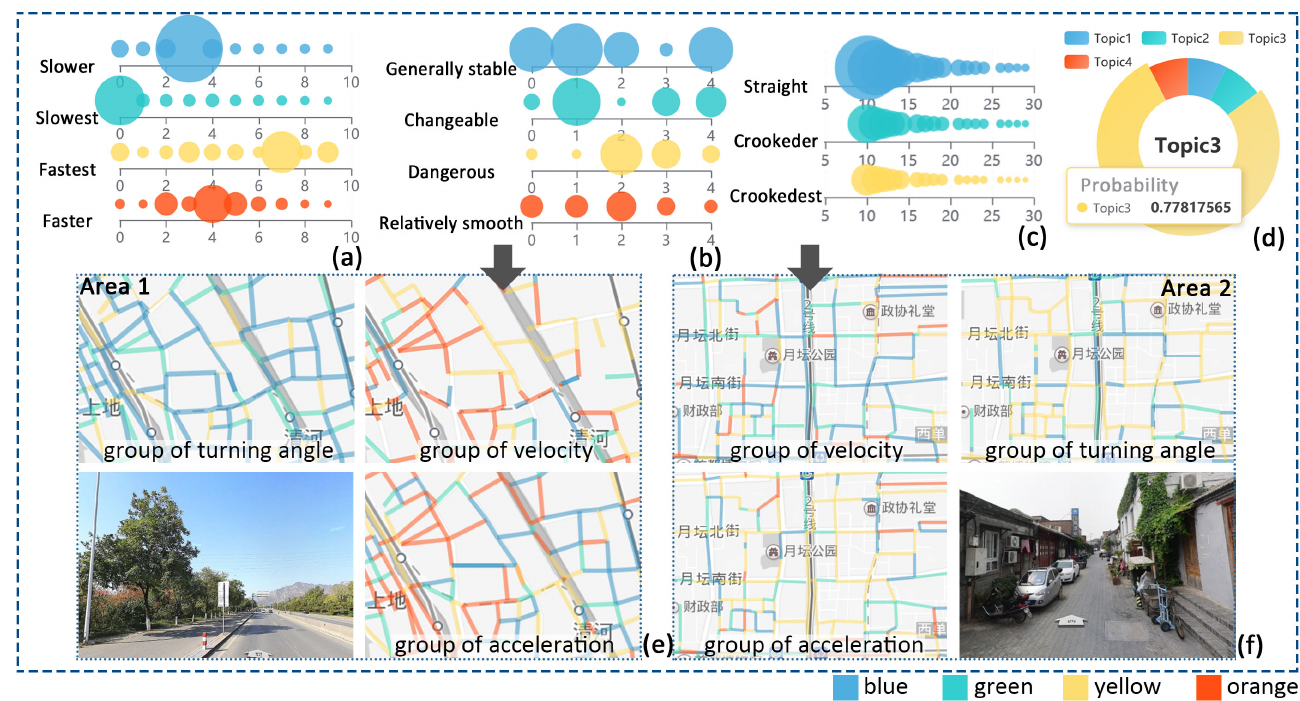
Figure 8. Moving semantics profiling. ( a ) The most important topics of velocity. ( b ) The most important topics of acceleration. ( c ) The most important topics of turning angle. ( d ) The topic distribution of a selected road segment. ( e , f ) Grouping of road segments with velocity, acceleration and turning angle in two local areas,